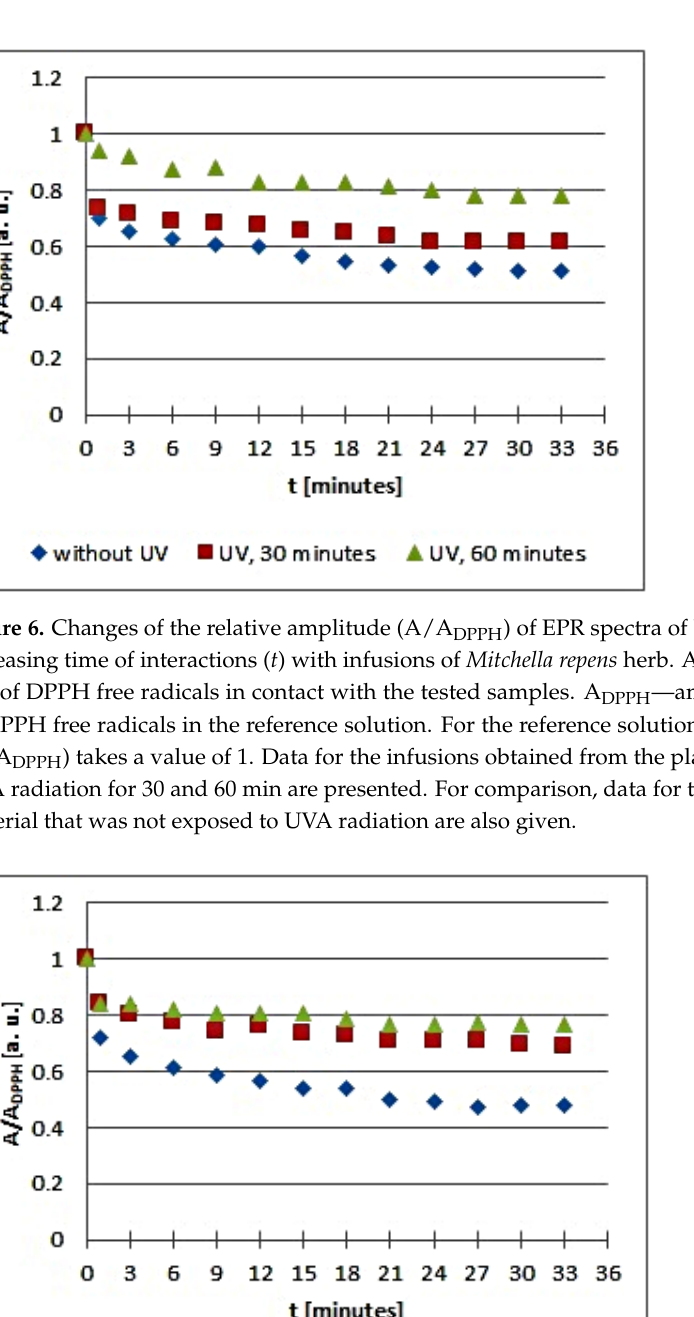
the plant material that was not exposed to UVA radiation are also given.